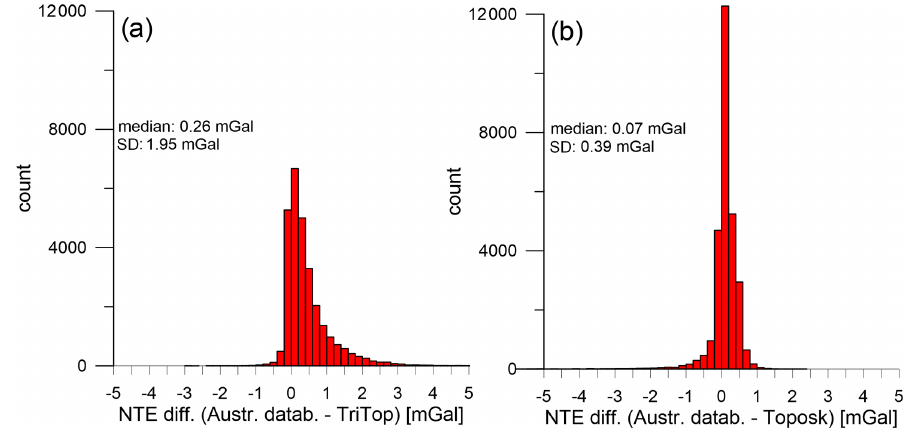
Figure D1. Comparison of the differences between original mass corrections from the Austrian gravity database and NTE calculations by means of programs (a) TriTop and (b) Toposk.